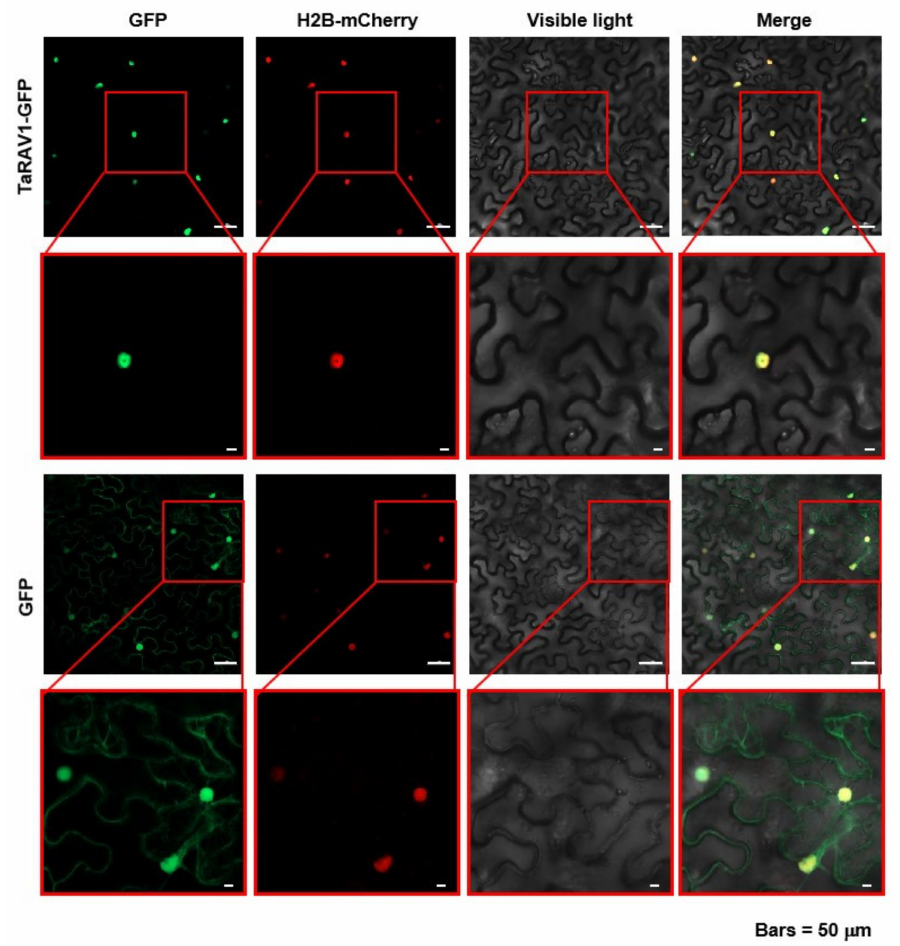
Figure 4. Subcellular localization of TaRAV1 protein. AtH2B-mCherry is a marker for nucleus localization. Constructs pSUPER:TaRAV1-GFP and 35S:AtH2B-mCherry were co-transformed into tobacco leaves using the Agrobacterium infiltration method. pSUPER:GFP and 35S:AtH2B-mCherry were co-transformed into tobacco leaves as a negative control. GFP and mCherry signals were detected by confocal microscopy 3 days after infiltration. Scale bars, 50 µ